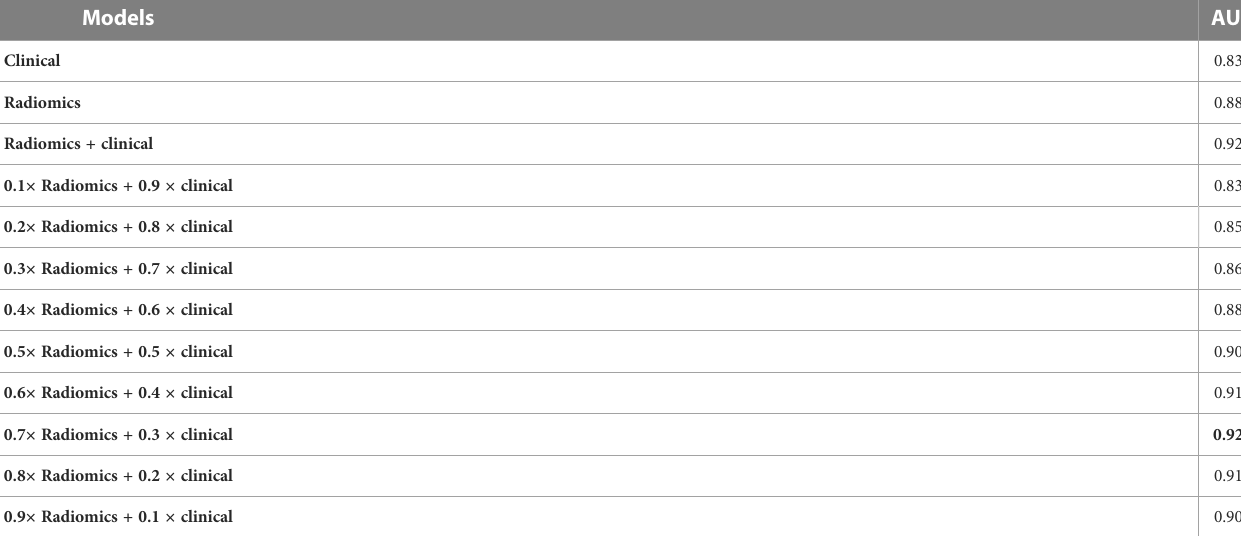
TABLE 4 AUC values of different models in the testing dataset.